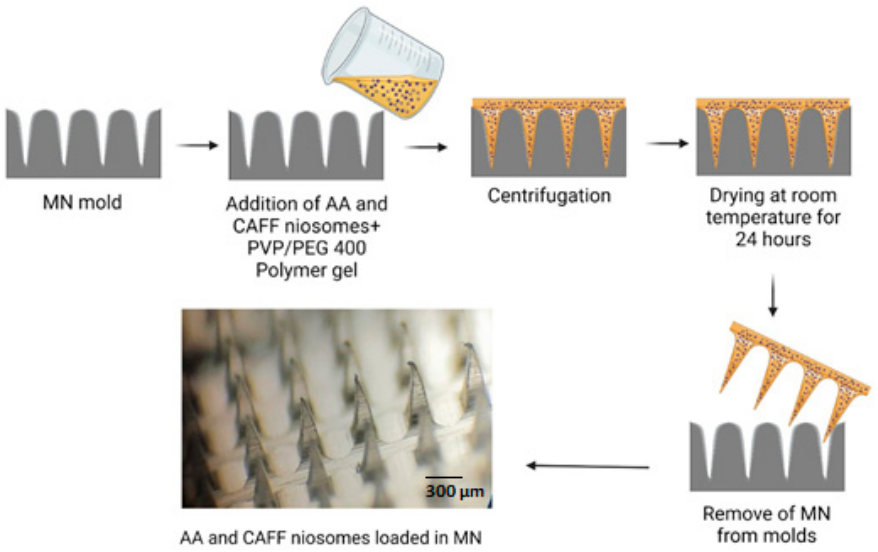
Figure 2. Schematic representation of the fabrication of MN loaded AA and CAFF niosomal nano- particles.